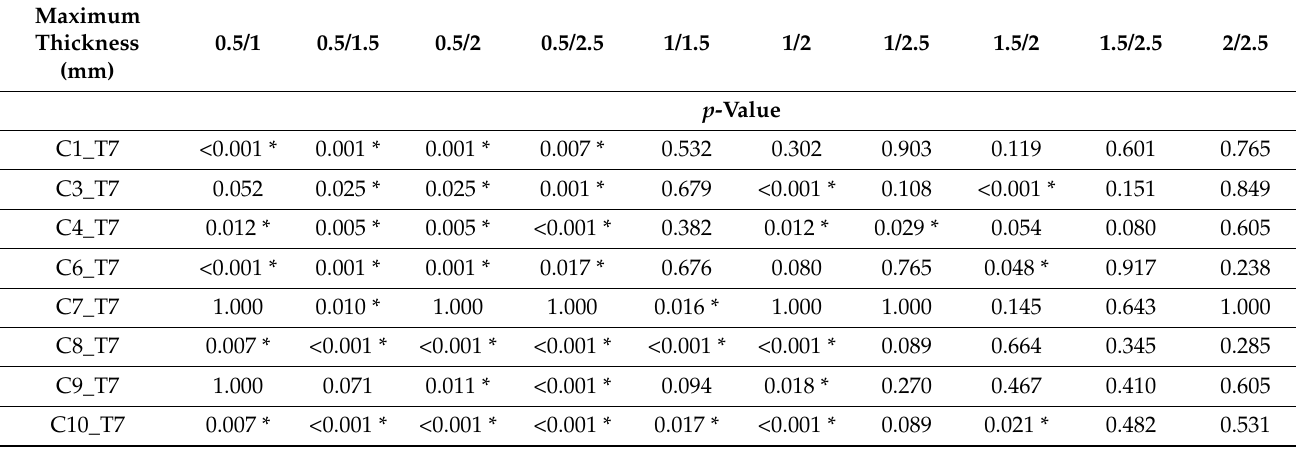
Table 2. Mann–Whitney U test results ( p -values) after comparing the maximum veneer thickness groups in pairs for each FDI criterion after a 7-year